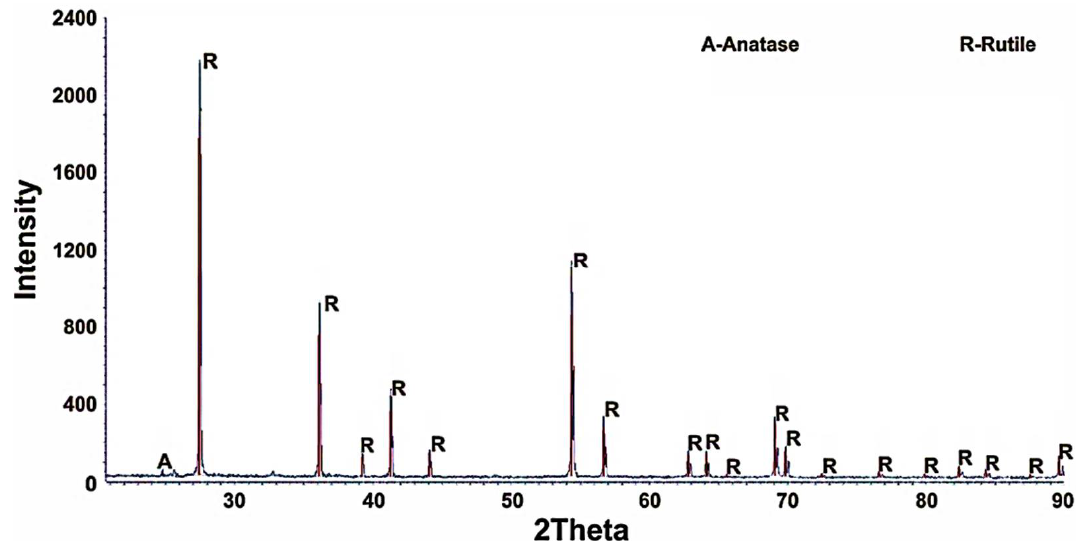
Figure 10. XRD pattern of rutile (900 °C, 120 min calcination time).